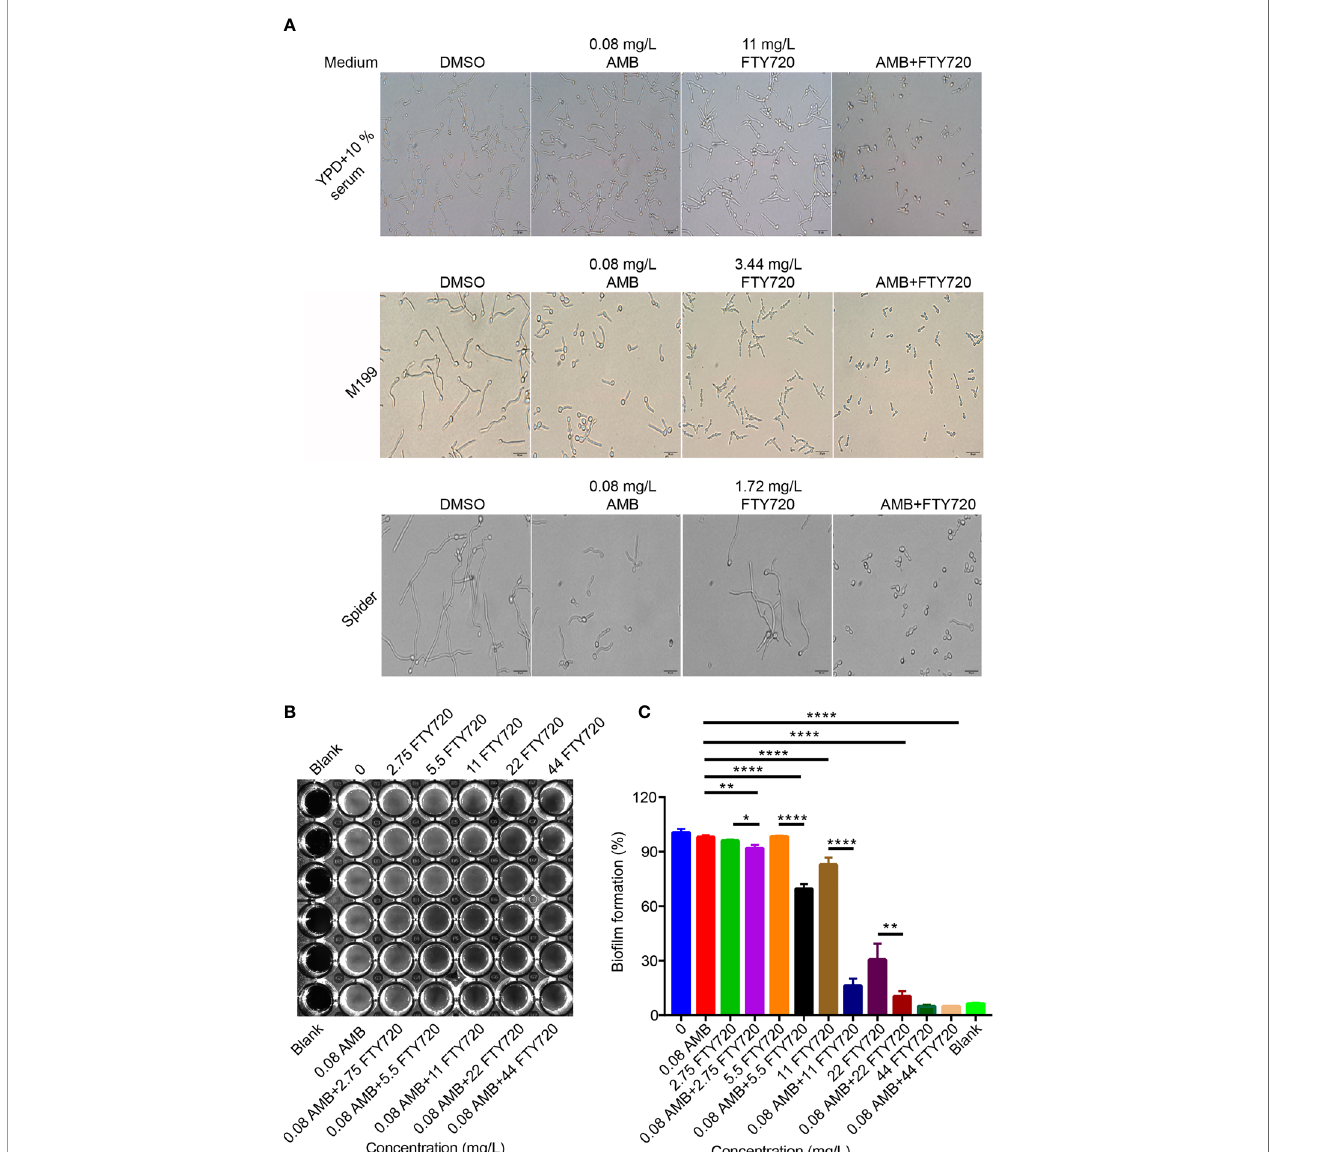
FIGURE 3 | Suppression of C. albicans fi lamentation and bio fi lm formation by FTY720 and AMB. (A) Cells were inoculated into different hyphae-inducing medium in the presence or absence of FTY720 and AMB and grown for 2 h at 37°C (Scale bar=20 m m). (B) Adhesive bio fi lm formation of C. albicans in RPMI medium supplemented with different concentrations of FTY720 and AMB in a 96-well plate and photos were taken after discarding supernatant. (C) In vitro activity of different concentrations of FTY720 and AMB at the early stage of bio fi lm formation after incubation in 96-well plate at 37°C for 4 h, as determined by XTT colorimetric readings at 490 nm. Error bars represent SDs of 3 technical replicates. Statistical signi fi cance was determined using one-way analysis of variance (ANOVA) with Tukey ’ s corrected post-hoc comparisons. * P < 0.05, ** P < 0.01, **** P <